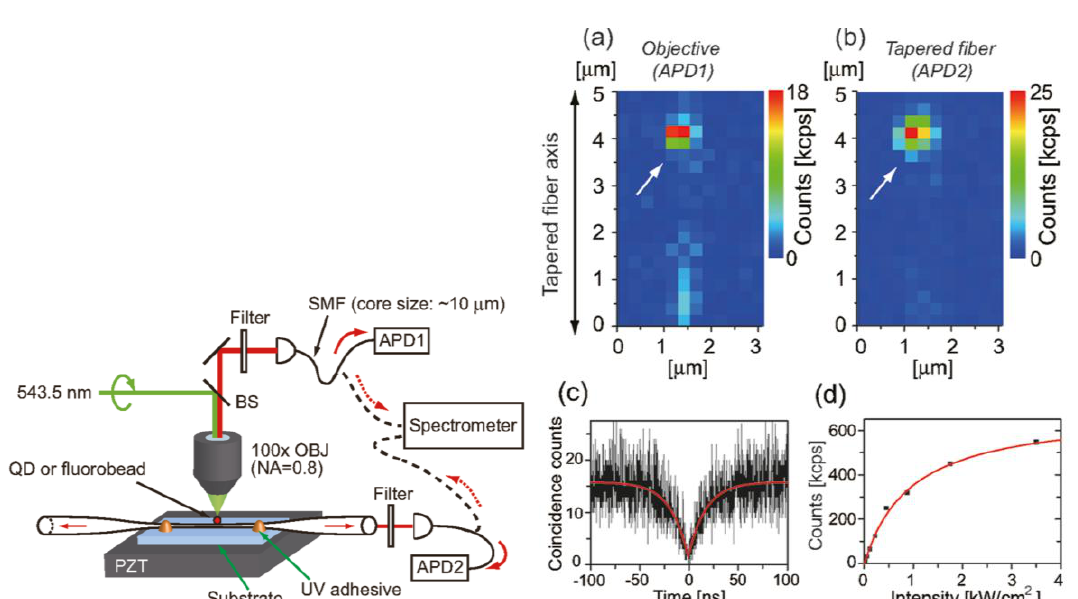
Figure 15. ( Left ) Schematic illustration of the setup. Note that the detection method was changed from APDs to a spectrometer, depending on the experiment. ( Right ) Scanning images of quantum dots on the ONF using ( a ) an objective and ( b ) an ONF. The quantum dot is next to the white arrow. ( c ) Second order photon correlation measurements. ( d ) Photon count from the quantum dot as a function of excitation laser intensity. Reprinted with permission from [101] . Copyright 2011 American Chemical